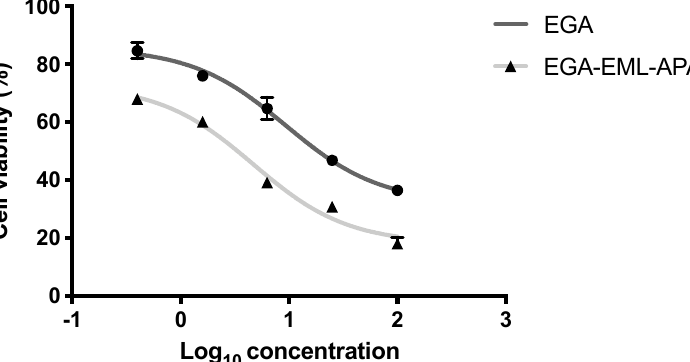
Figure 8. Cell viability evaluation using the MTT assay after 24 h of treatment with EGA and EGA- EML-APA. Data are expressed as mean ± SD. Abbreviations: EGA, ellagic acid; EML, emulsomes; APA, apamin.